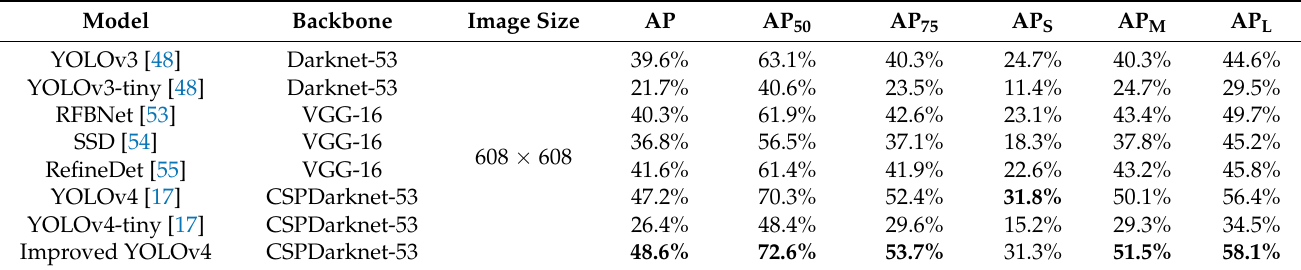
Table 8. Accuracy performance with augmented dataset (30,000